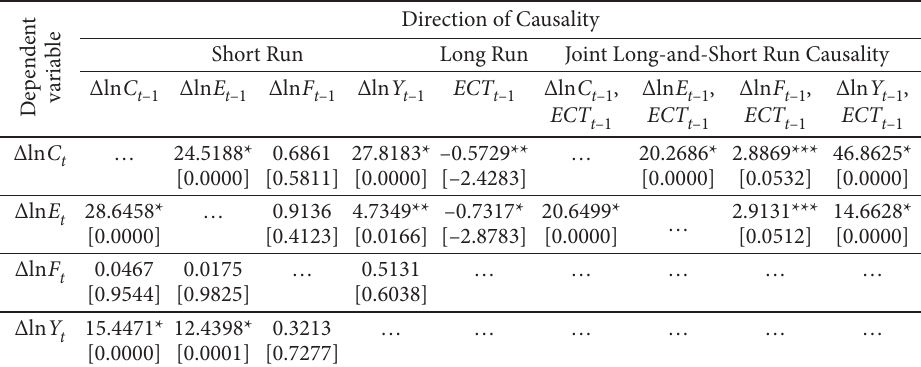
Table 5. The VECM Granger Causality